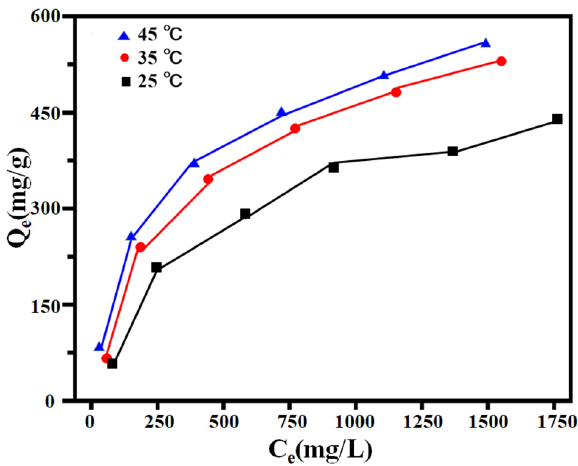
Figure 5. The comparison of the different temperatures (25 °C, 35 °C and 45 °C) on the adsorption capacity ( Q e , mg/g) at different initial concentrations ( C e , mg/L).